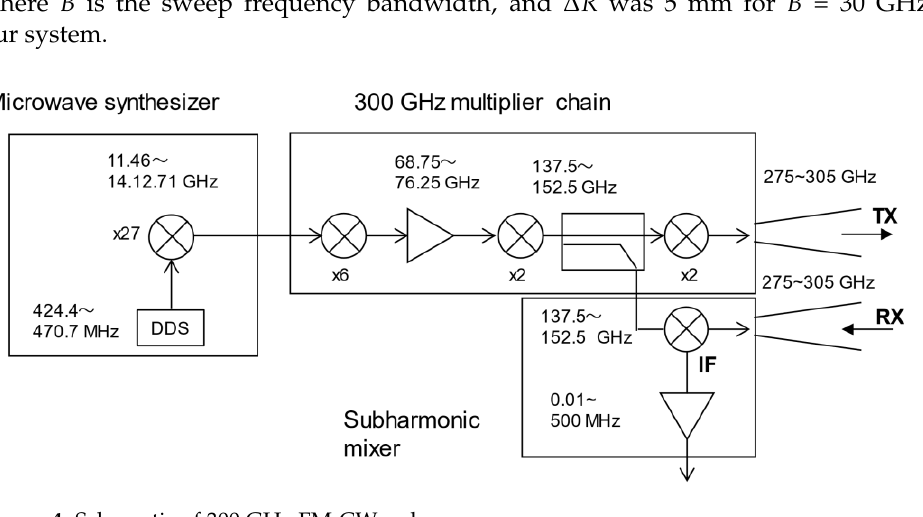
Figure 4. Schematic of 300 GHz FM-CW radar.